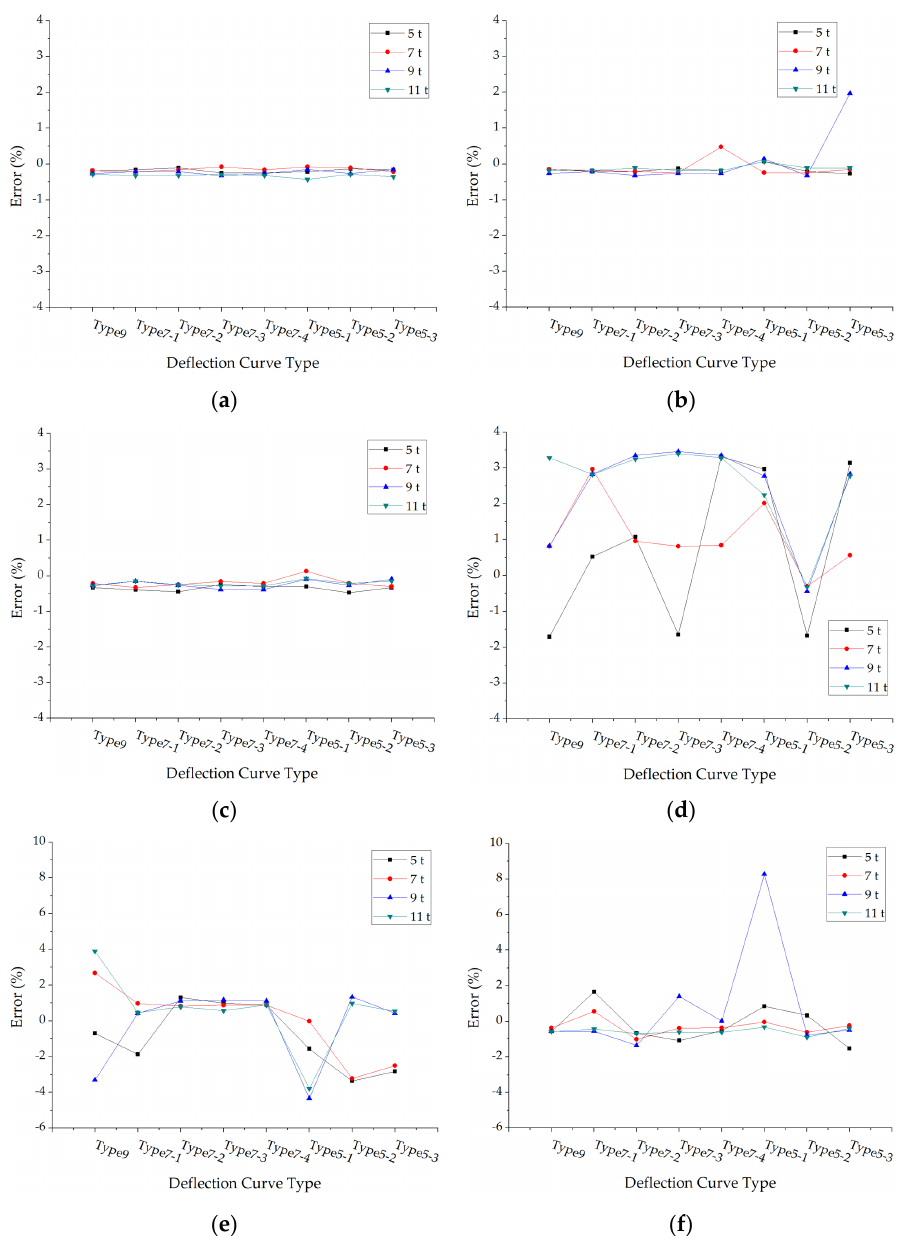
Figure 11. The errors of back calculated subgrade modulus under different deflection curve types: ( a ) Structure 1; ( b ) Structure 2; ( c ) Structure 3; ( d ) Structure 4; ( e ) Structure 5; ( f ) Structure 6.